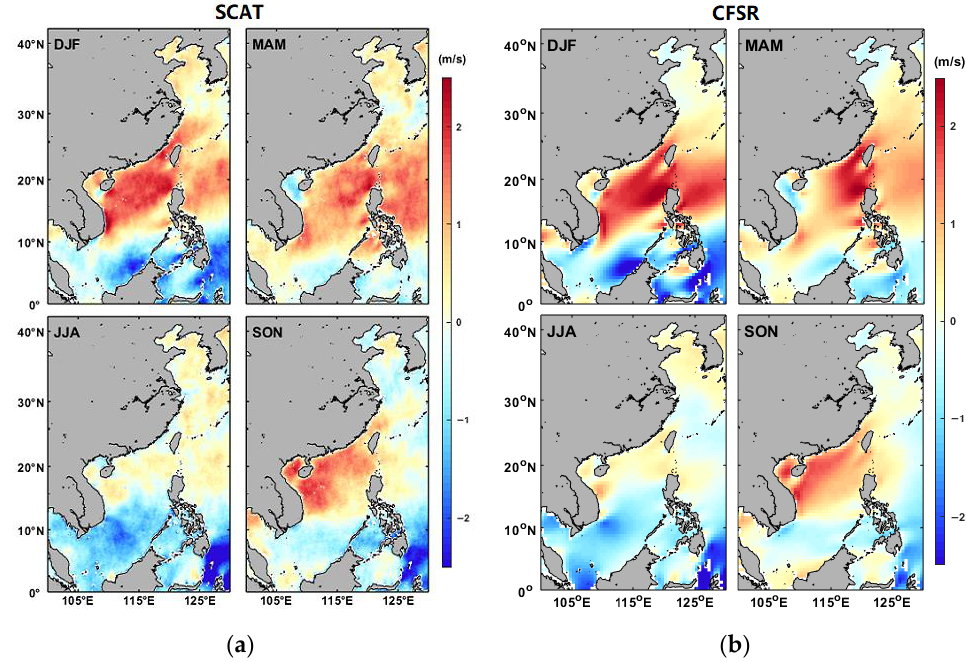
Figure 9. The LVs of CSEOF second mode of scatterometer ( a ) and CSFR ( b ) wind speeds.